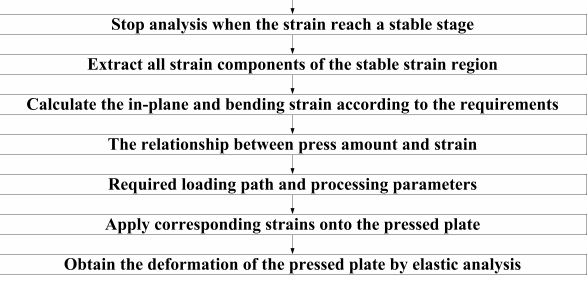
Figure 9. Simplified deformation simulation